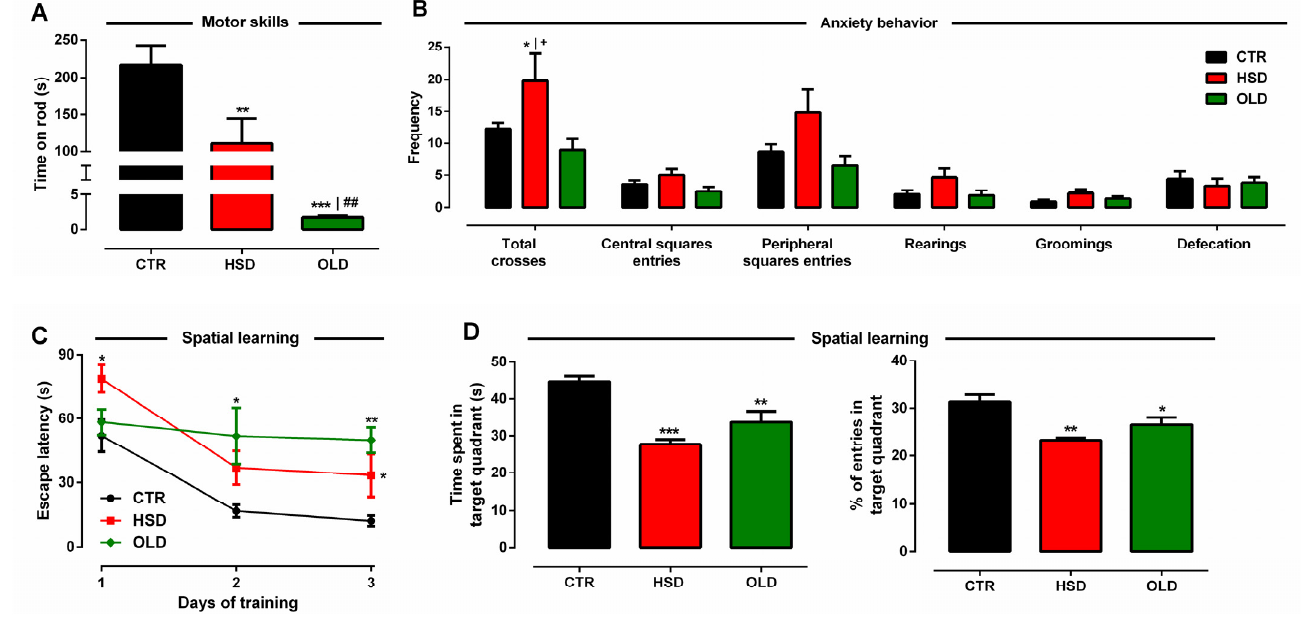
Figure 4. Motor, behavioral, and cognitive assessments. ( A ) Motor skills’ assessment by time on rod (s) in a rotarod test, ( B ) behavioral assessment by frequency of total crosses, central and peripheral squares entries, rearings, groomings, and defecation in an open-field test, ( C ) spatial learning assessment by latency time (s) to find the hidden platform in a water maze test, ( D ) memory assessment by time spent (s), as well as the number of entries in the target quadrant in a water maze test assessed in rats fed a standard chow (CTR, n = 7) and a high-sucrose diet (HSD, n = 7) until 6 months from weaning and in middle-aged (20 months old) animals fed a standard chow (OLD, n = 7). Points and bars represent the mean ± SEM (one-way ANOVA Newman–Keuls). * p < 0.05, ** p < 0.01, *** p < 0.001 when compared to CTR, + p < 0.05 when compared to OLD, and ## p < 0.01 when